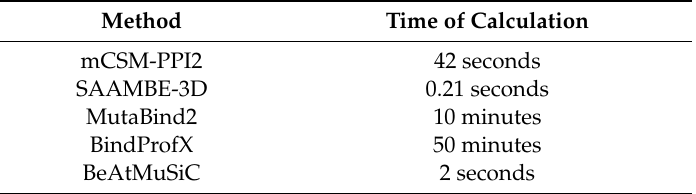
Table 3. Comparison of time of calculation for a single prediction between di ff erent ∆∆ G